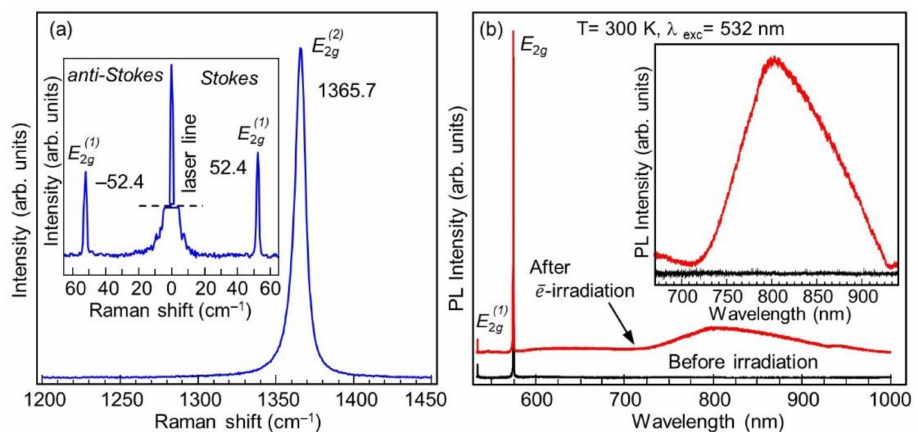
( 2 ) symmetry phonon. 2 g ( 1 ) symmetry phonon. 2 g